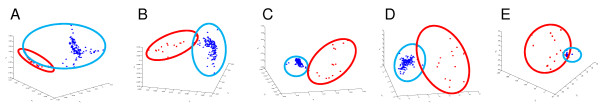
Visualization of 3D embeddings for gene-expression data (breast cancer). 3D visualization of embedding results for lung cancer gene-expression data: (a) XSSGE, (b) X˜GES, (c) X˜GEUS, (d) X˜PCAS, (e) X˜PCAUS. The 3 axes correspond to the primary 3 eigenvalues obtained via different DR methods (SSAGE, consensus-GE and consensus-PCA), while the colors of the objects (red and blue) are based on known class information (cancer and non-cancer, respectively). Note the relatively poor performance of (a) semi-supervised DR compared to (b)-(e) consensus DR. Both supervised ((b) and (d)) and unsupervised ((c) and (e)) consensus DR show relatively consistent separation between the classes with distinct, tight clusters. The best clustering accuracy for this dataset was achieved by (c) unsupervised consensus GE (X˜GEUS).